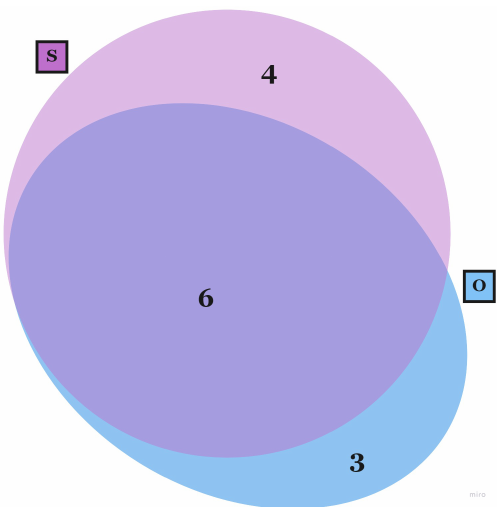
Figure 2. Venn Diagram representing the number of selected articles that realize a real flight task (RF Articles), using: Objective (O) or Self (S) Assessment in different combinations. No RF articles employing a performance assessment (P) approach were